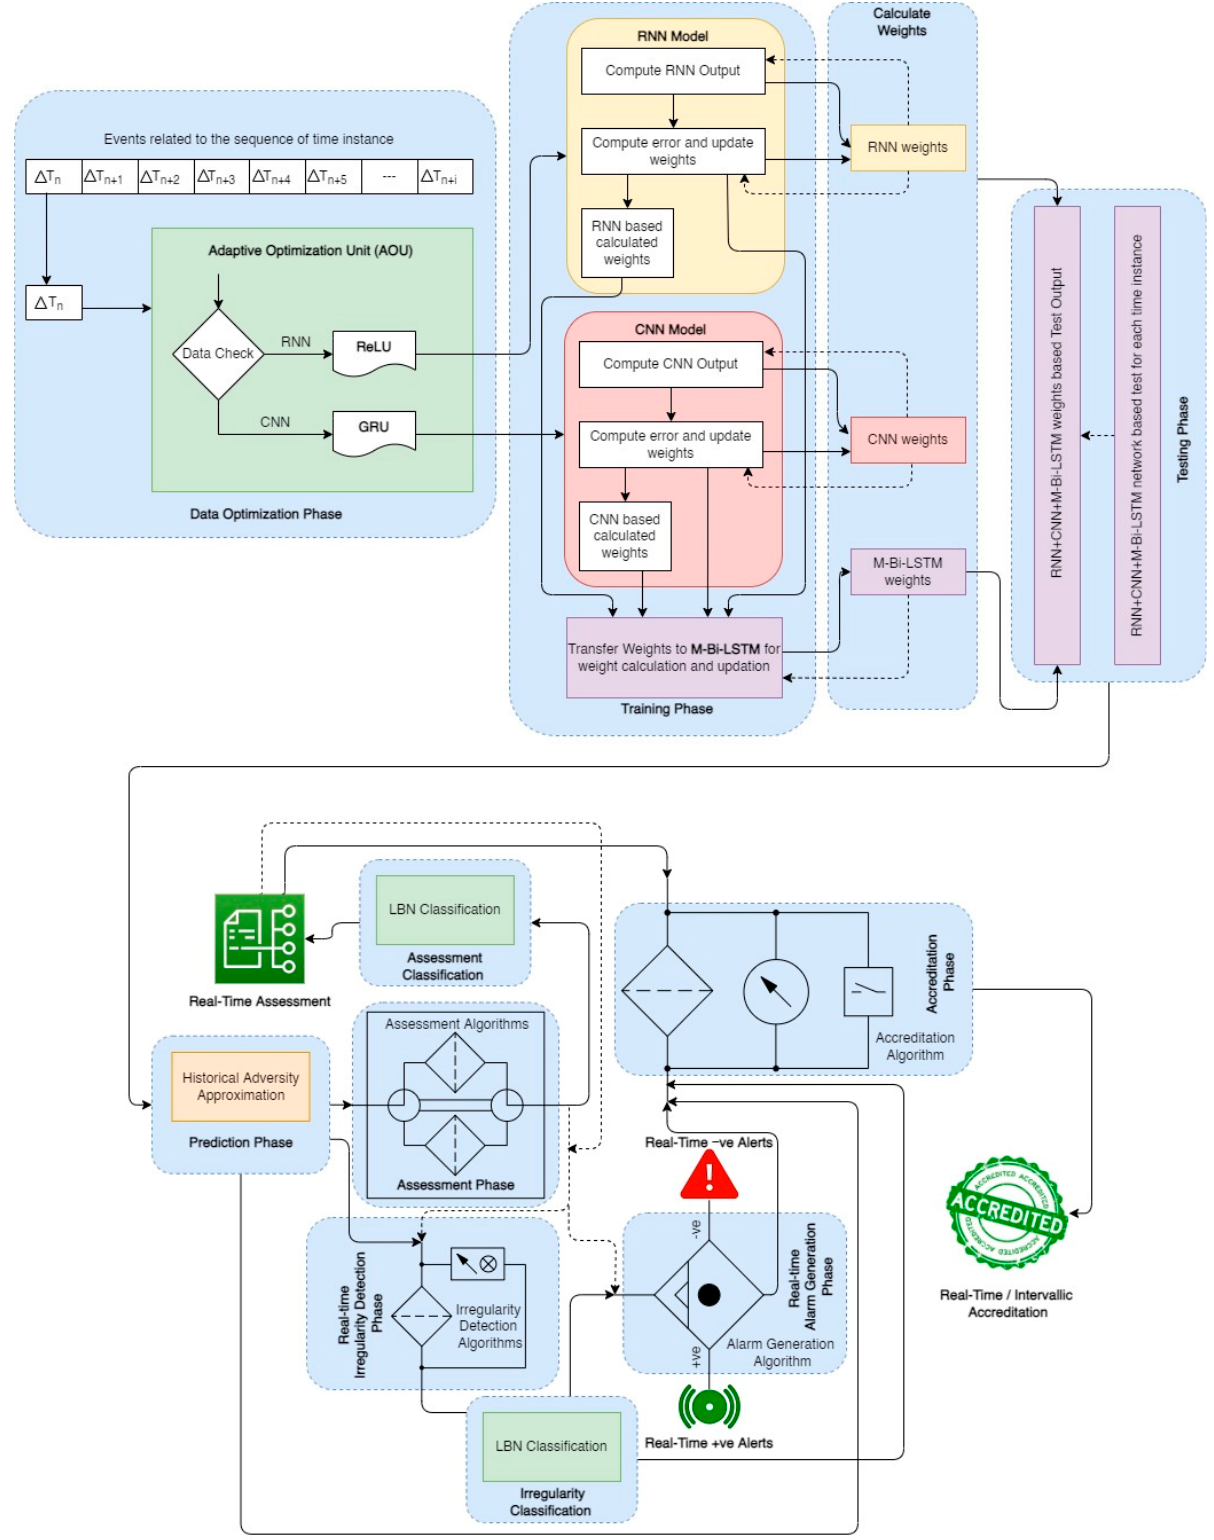
Figure 4. The proposed model for assessment, irregularity detection, and alarm generation under Education 4.0.